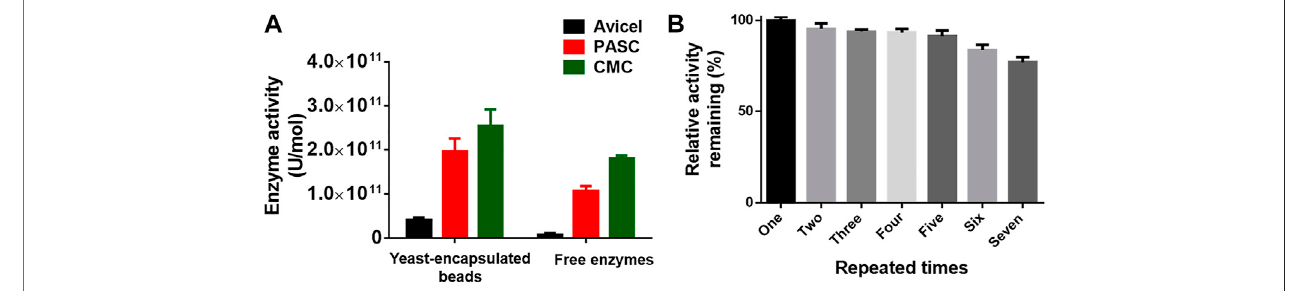
FIGURE 4 | (A) Enzyme activity of the encapsulated yeast cells and free enzymes against different cellulose substrates. (B) Remaining enzyme activity of the encapsulated yeast cells after repeated use. The duration for each assay is ~40